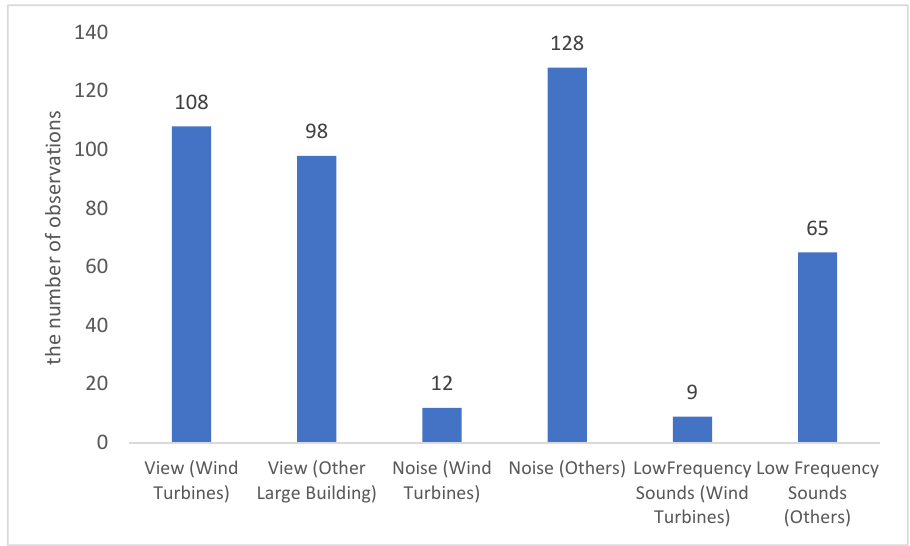
Figure 6. Situation around the place of residence.